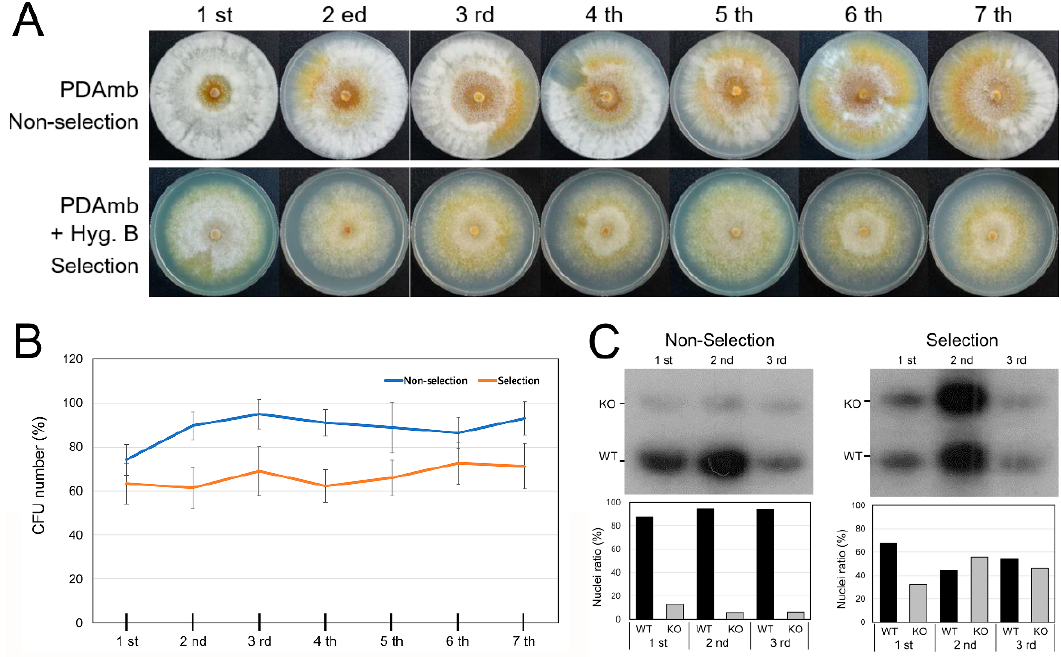
Figure 6. Colony morphology of heterokaryon with and without continuous hygromycin B selection pressure with continuous passage. ( A ) Morphology of CpRan1 -null mutant (TdRan1-Het1) on nonselective, PDAmb, (upper panel) and selective, PDAmb + Hyg. B; PDAmb supplemented with hygromycin B, (lower panel) media. The number of passages was displayed on the top of the plate. ( B ) Number of germinating spores (CFU) harvested from TdRan1-Het1. ( C ) Southern blot analysis of wild-type (WT) and CpRan1 -null (KO) nuclei after the successive cultures on non-selective and selective media (upper panels). Densitometry of the hybridizing bands in the corresponding upper panel using Image J. PDAmb and PDAmb + Hyg. B are used for the non-selective and selective media, respectively.